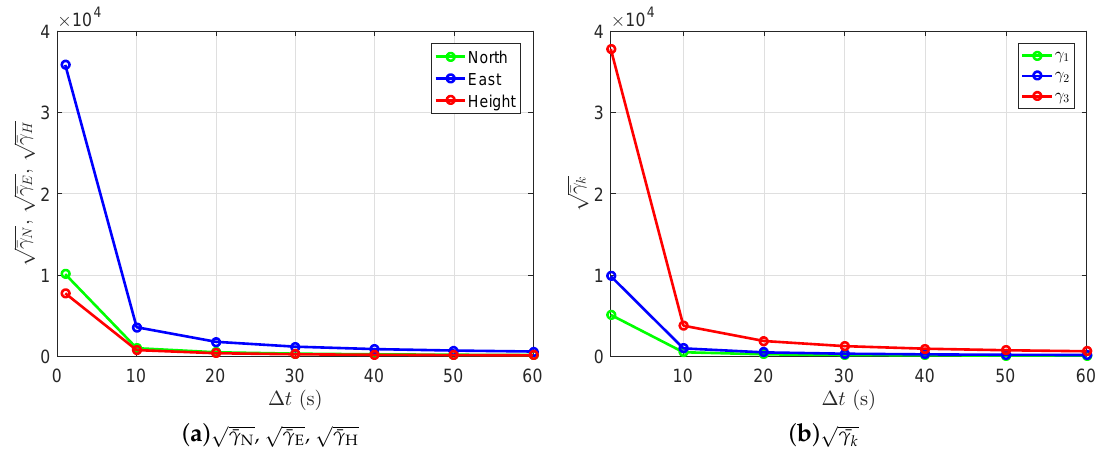
Figure 17. Square roots of the daily average γ N , γ E , γ H ( a , Equation (29)), and γ k ( b , Equation (19)). The L1 data of baseline CUAA-CUBB on DOY 240, 2018, was used for the